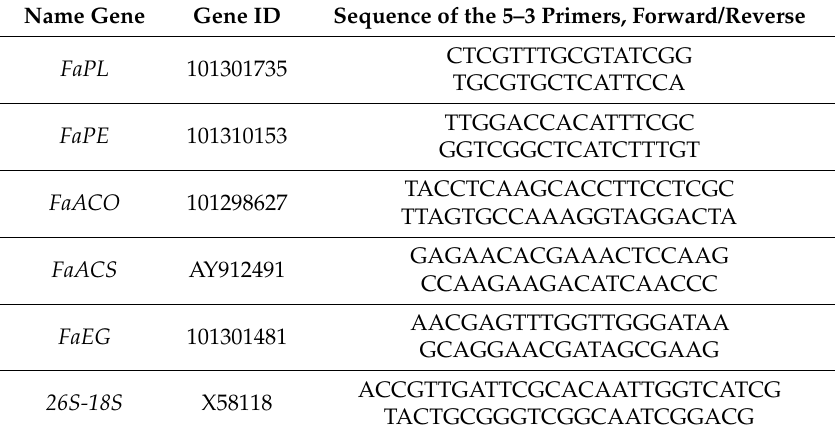
Table 2. Gene-specific oligonucleotides primers pairs used for RTqPCR. The accession number of each gene was obtained from